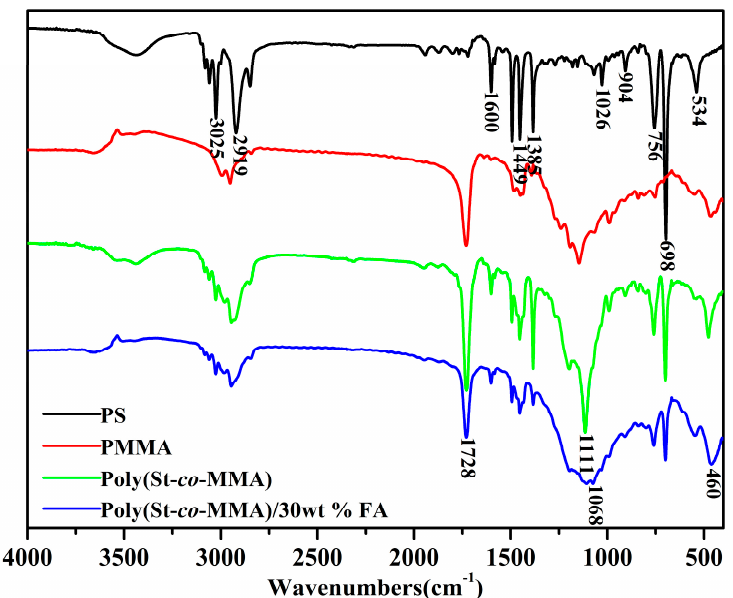
Figure 2. FTIR spectra of PS, PMMA, poly(St- co -MMA), and poly(St- co -MMA)/30 wt.% FA micro-